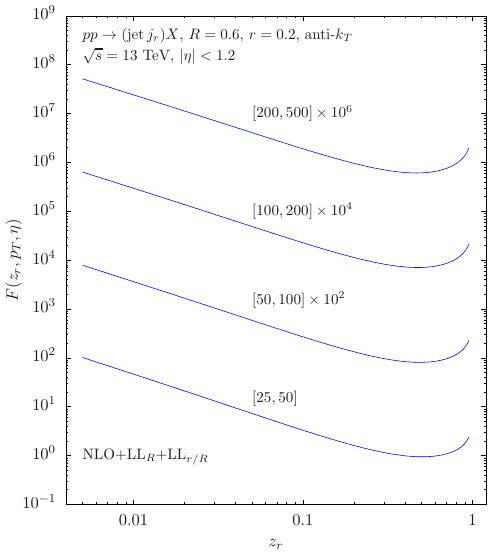
Figure 5 . The subjet distribution measured on an inclusive jet sample pp ! (jet j r ) + X , using anti-k T with jet radius R = 0 : 6 and subjet radius r = 0 : 2, for representative LHC kinematics p s = 13 TeV, j (cid:17) j < 1 : 2. Shown are the NLO+LL R +LL